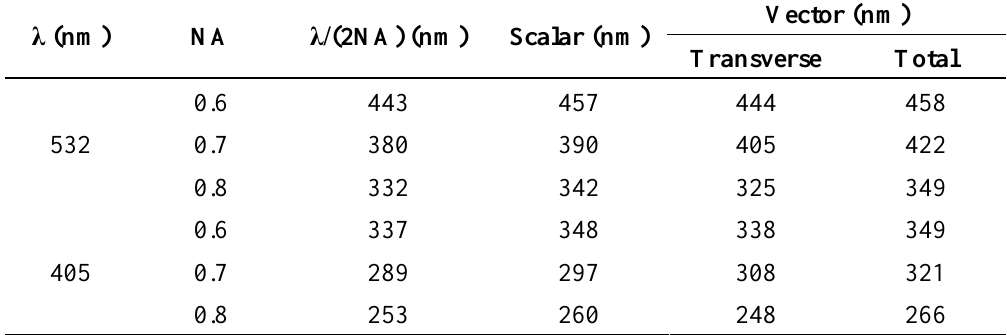
Table 2. Comparison of micrograting size using scalar diffraction theory and vector diffraction theory